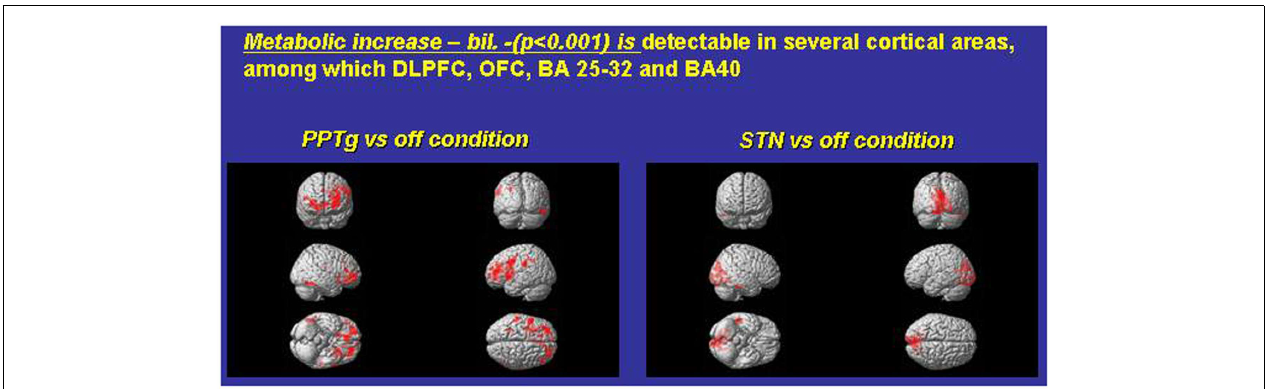
FIGURE 1 | Exemplary FDG consumption comparing, in the same PD subjects, the condition only PPTg-ON (left panel) versus the condition STN-ON (imaging were performed in Pisa, under the supervision of Dr. Ceravolo and Dr.Volterrani; for details, see Ceravolo et al., 2011) .